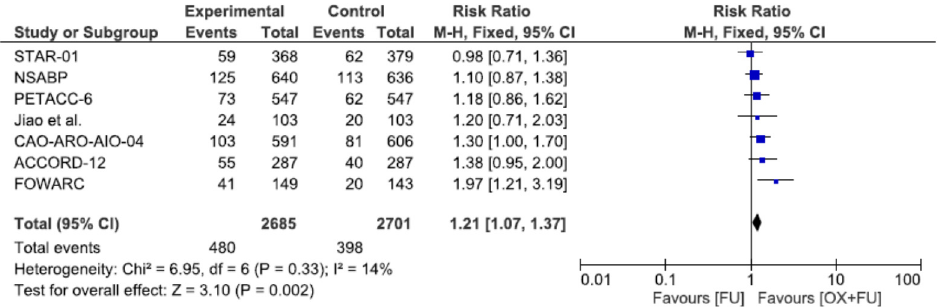
Figure 3. Forest plot of risk ratio for pathological complete response.